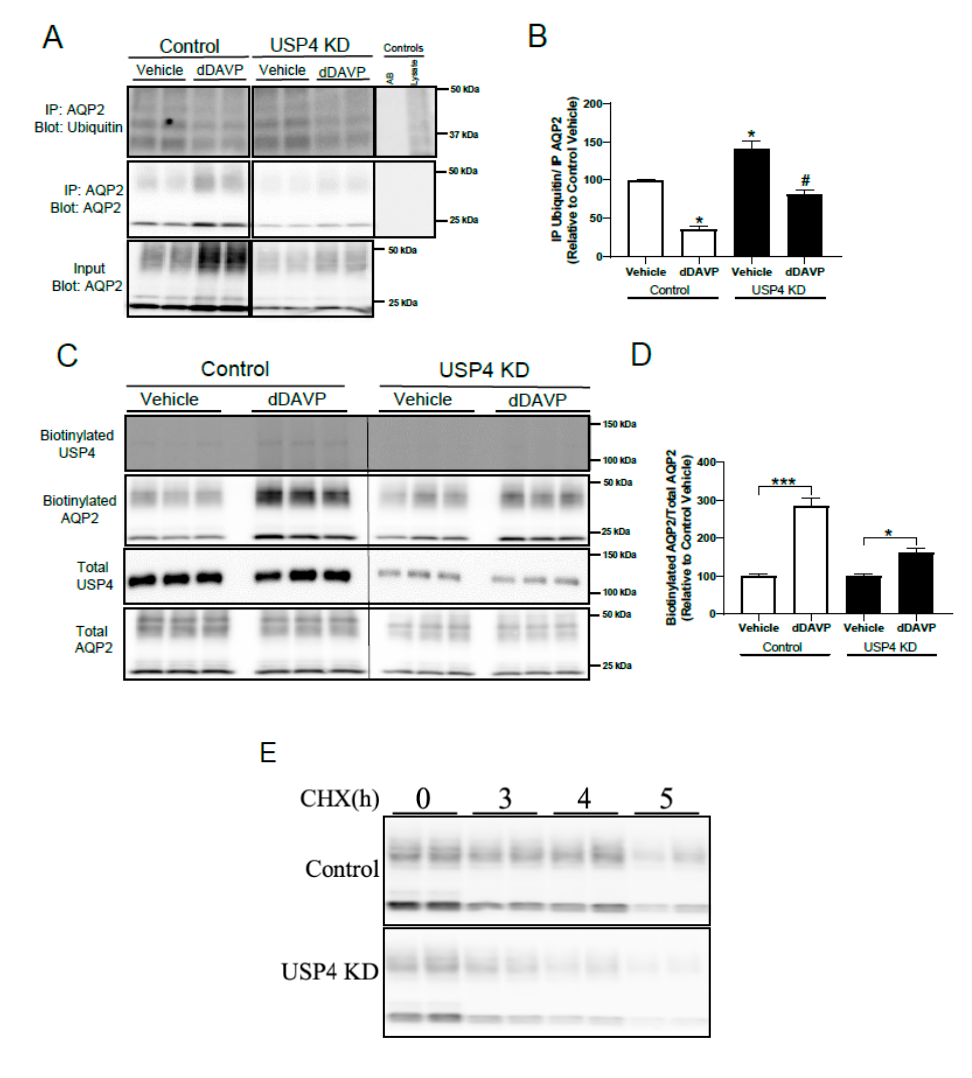
Figure 5. Knockdown of USP4 in mpkCCD14 cells alters AQP2 ubiquitylation levels, apical membrane accumulation, and protein half ‐ life. mpkCCD14 control and USP4KD cells were grown in the presence of dDAVP for 4 days to induce AQP2 expression. For immunoprecipitation (IP) studies, cells were washed with DMEM/F12 and incubated in DMEM/F12 for 2 h at 37 °C. Subsequently, cells were treated with either vehicle or dDAVP for 20 min prior to immunoprecipitation (IP) using an anti ‐ AQP2 antibody. For biotinylation studies, cells were washed twice with DMEM/F12 and subsequently treated with either vehicle or dDAVP for 20 min at 37 °C. For half ‐ life studies, control and USP4 knockdown mpkCCD14 cells were washed with DMEM/F12 and subsequently treated with cycloheximide for different time periods (0, 3, 4, and 5 h). ( A ) Representative immunoblots from immunoprecipitation of ubiquitylated and total AQP2 levels. Breaks in the images are to show the immunoprecipitation controls (antibody (AB) alone or lysate alone) next to the samples. ( B ) Summarized data of ubiquitylated AQP2 to total AQP2 (relative to control vehicle group). Each bar represents mean ± S.E.M obtained from three independent experiments (n = 6). * indicates p < 0.05 relative to control conditions and # indicates p < 0.05 relative to vehicle treatment in USP4 knockdown cells. ( C ) Representative immunoblots from biotinylation studies are shown. ( D ) Summarized data of biotinylated AQP2 to total AQP2 (relative to control vehicle group). Each bar represents mean ±